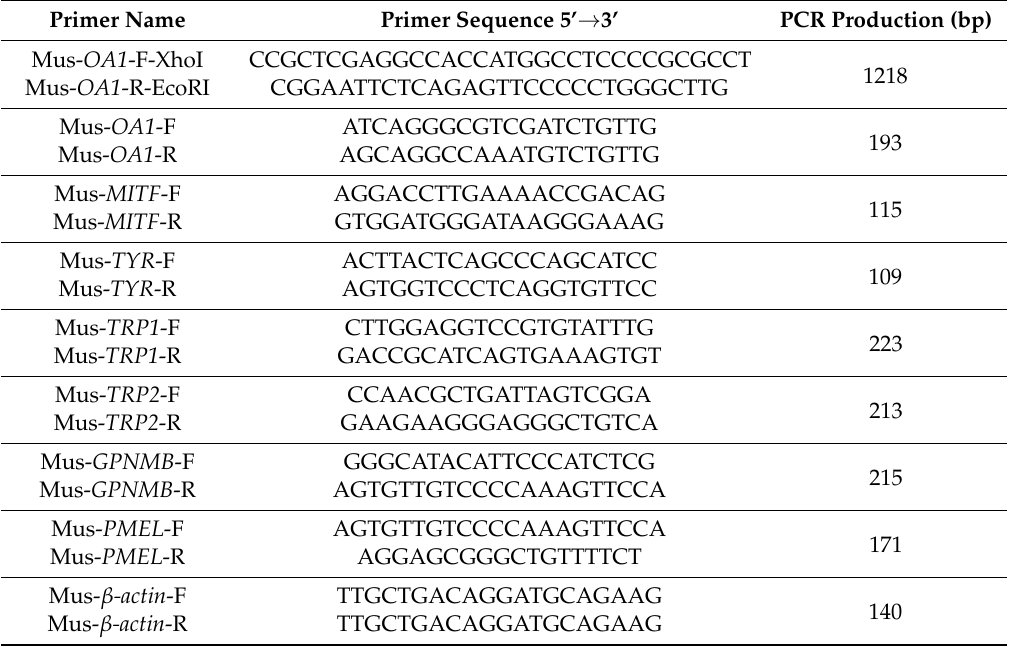
Table 1. Primers used in this